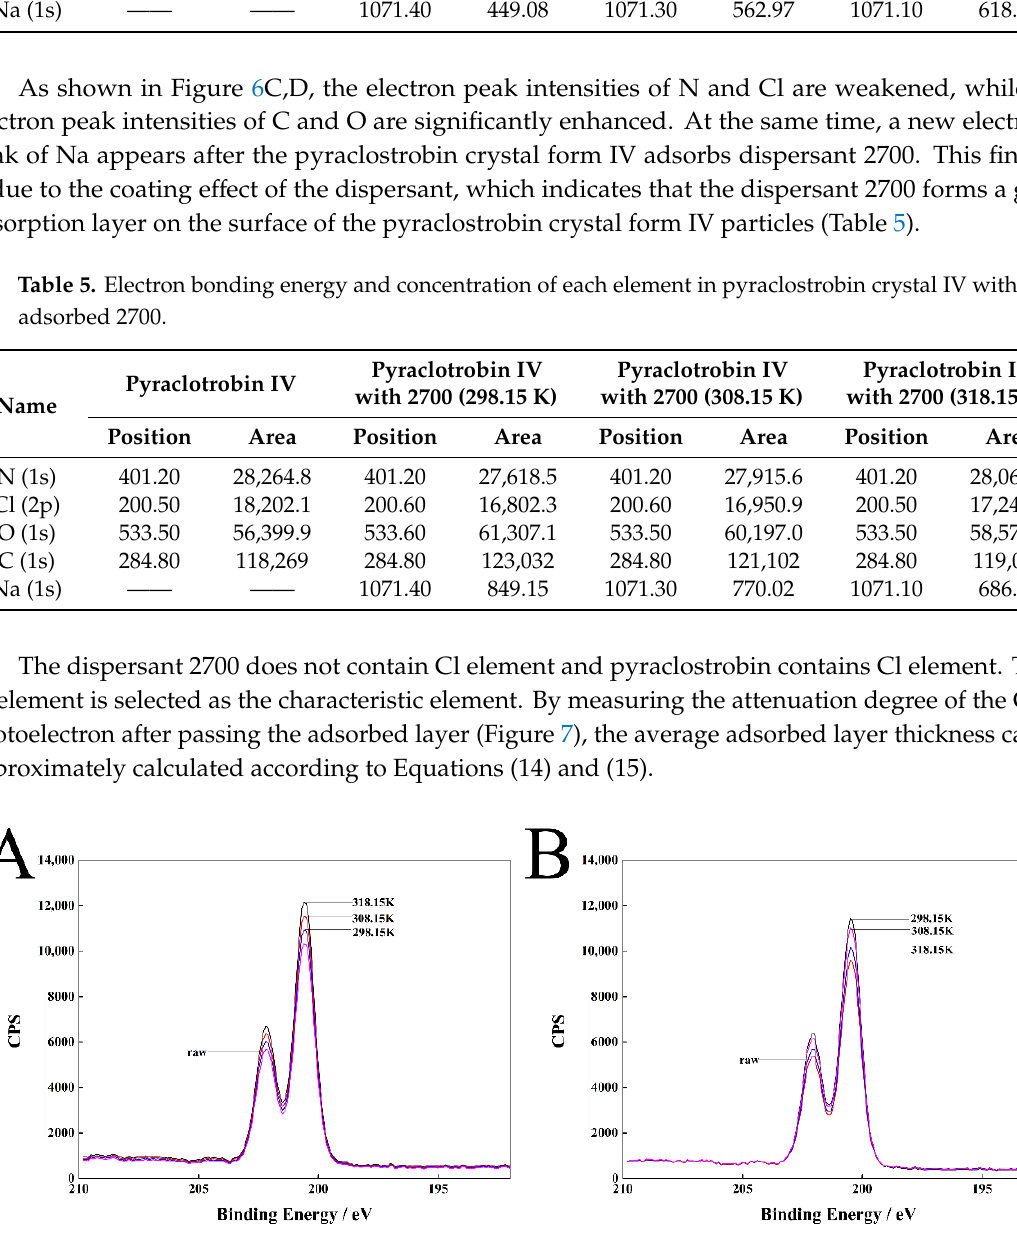
Figure 7. Cl 2p XPS spectrum of pyraclostrobin crystal II particle surfaces ( A ) and pyraclostrobin crystal IV particle surfaces ( B ) with adsorption dispersant 2700 at different temperatures.